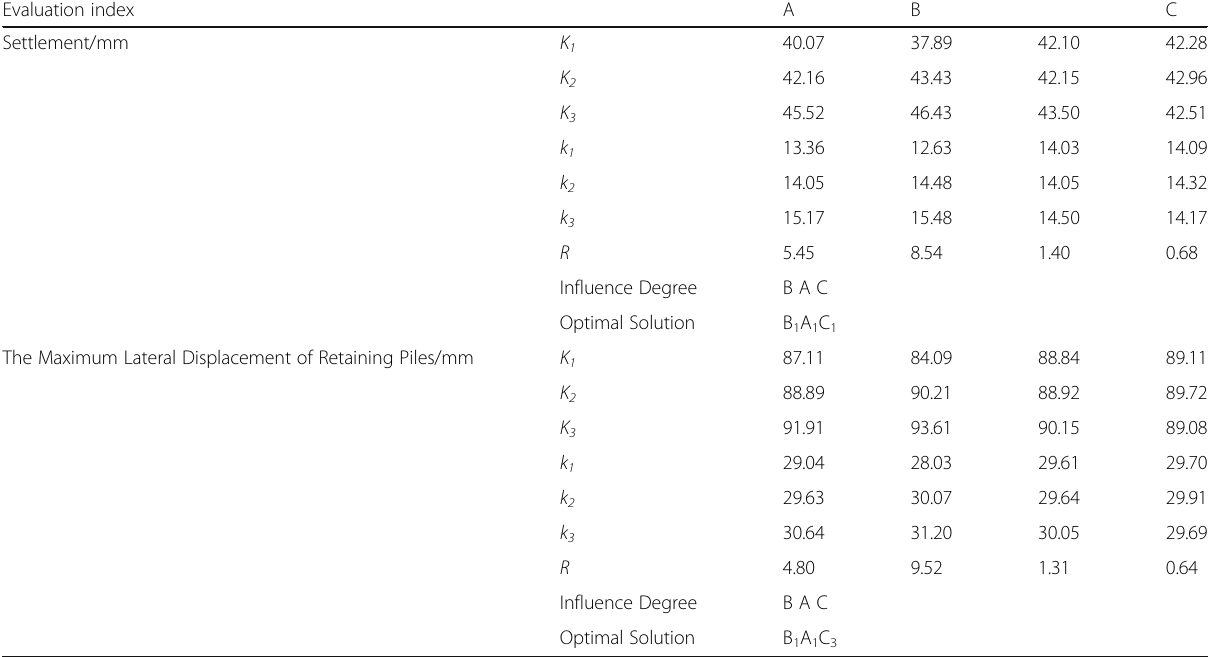
Table 8 Analysis of test results Evaluation